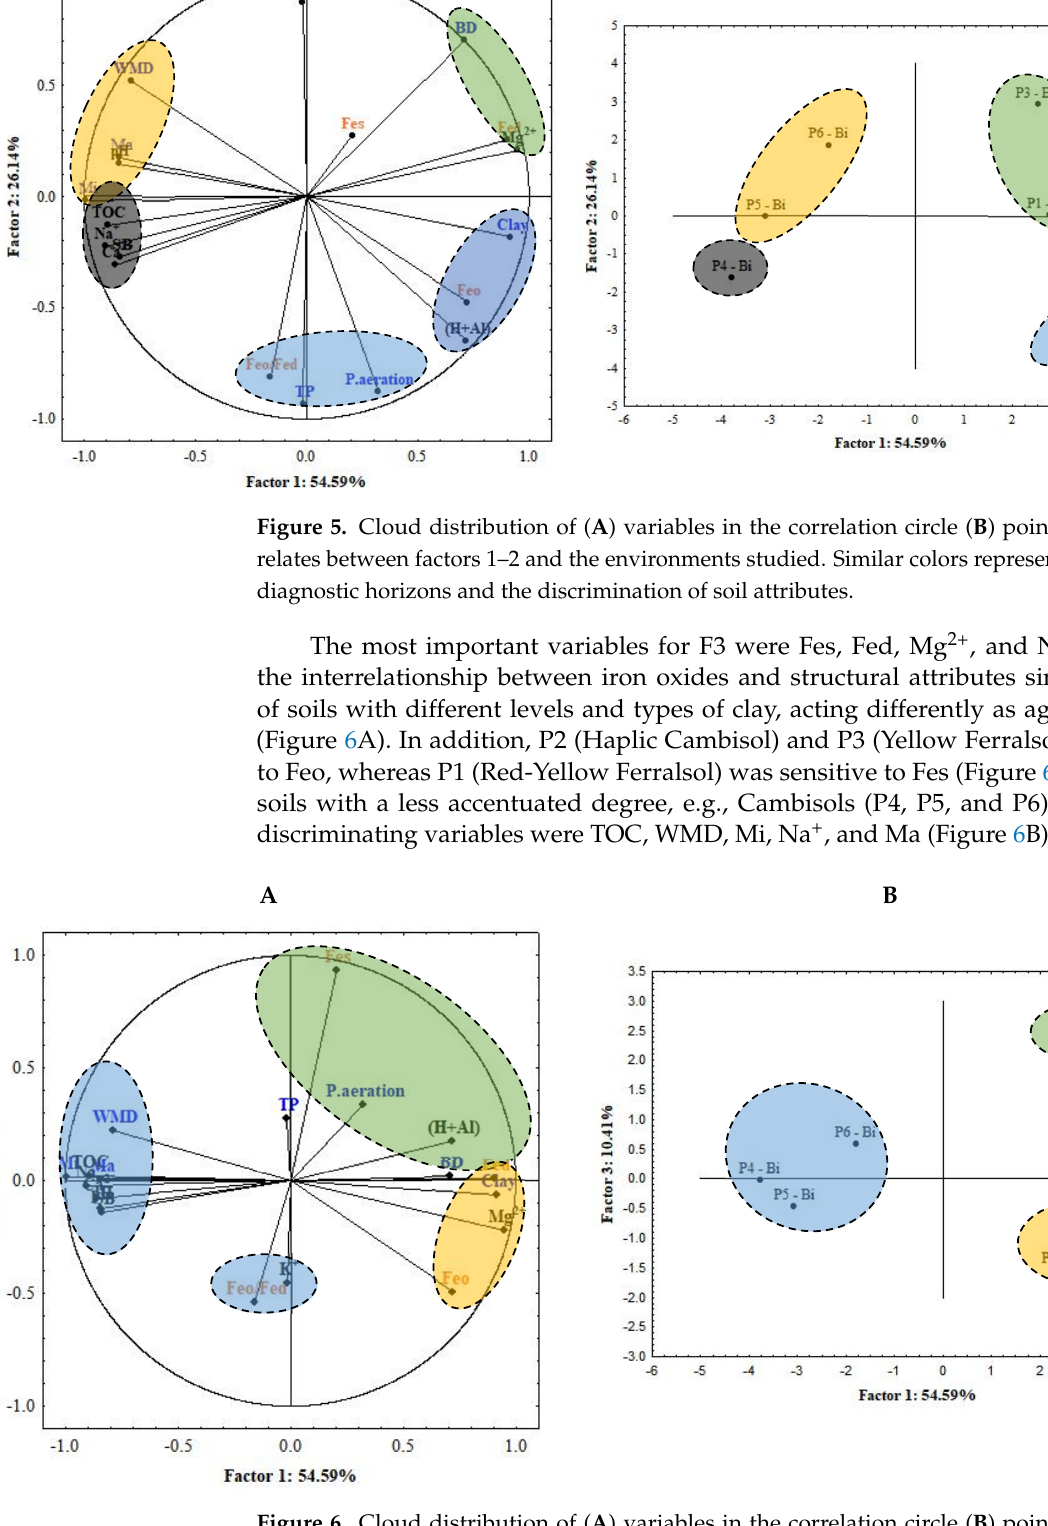
Figure 6. Cloud distribution of ( A ) variables in the correlation circle ( B ) points representing the relates between factors 1–3 and the environments studied.